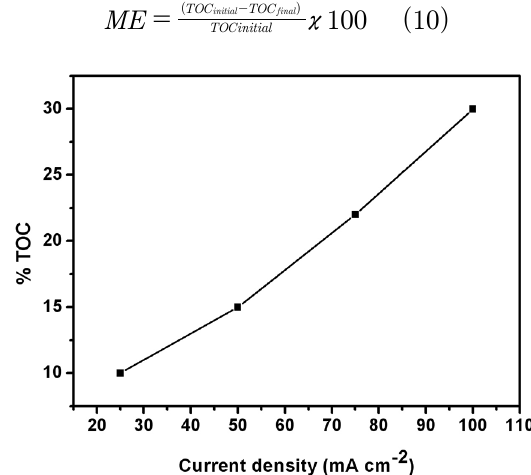
Figure 7. The concentration decay curves (λ = 388 nm) as a function the time.